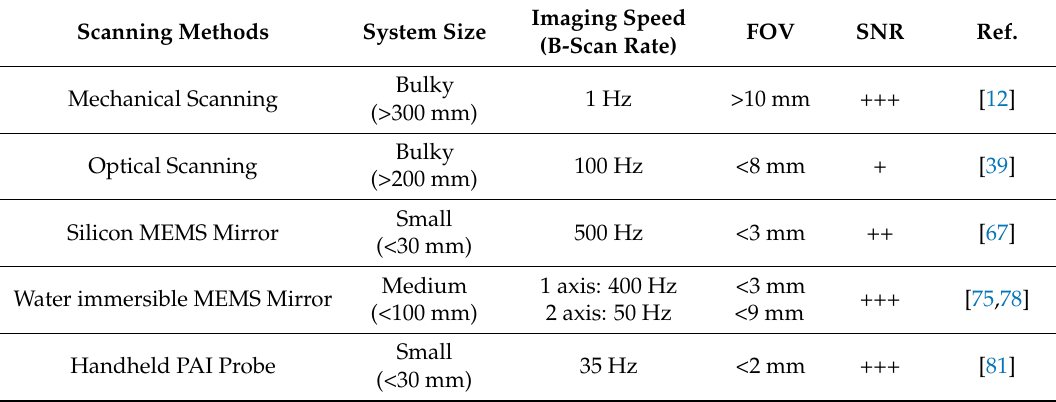
Table 1. Comparison of the PAI system based on MEMS scanning